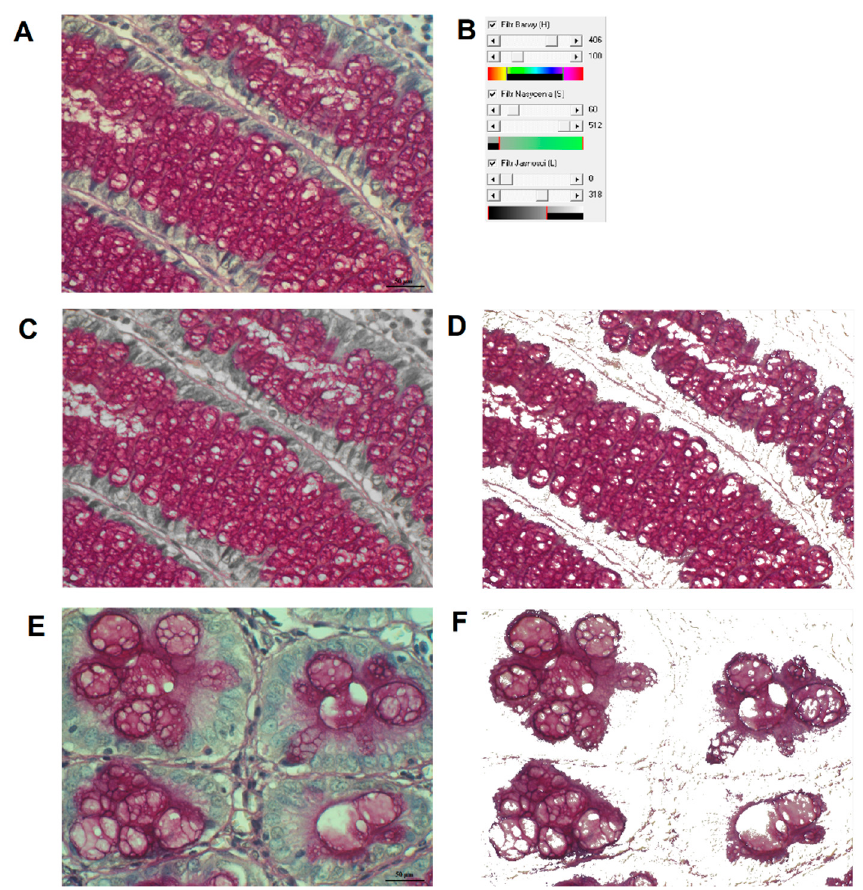
Figure 6. Typical steps for digital image analysis by using Filter HSV program concerning expression of PAS+ mucins in control colon ( A ) and colorectal cancer tissue samples ( E ). Row image ( A ); program settings for HSV space ( B ); successive stage of segmentation of PAS+ reaction ( C , D ); segmented PAS reaction ( D ); raw image ( E ); segmented PAS+ reaction ( F ).